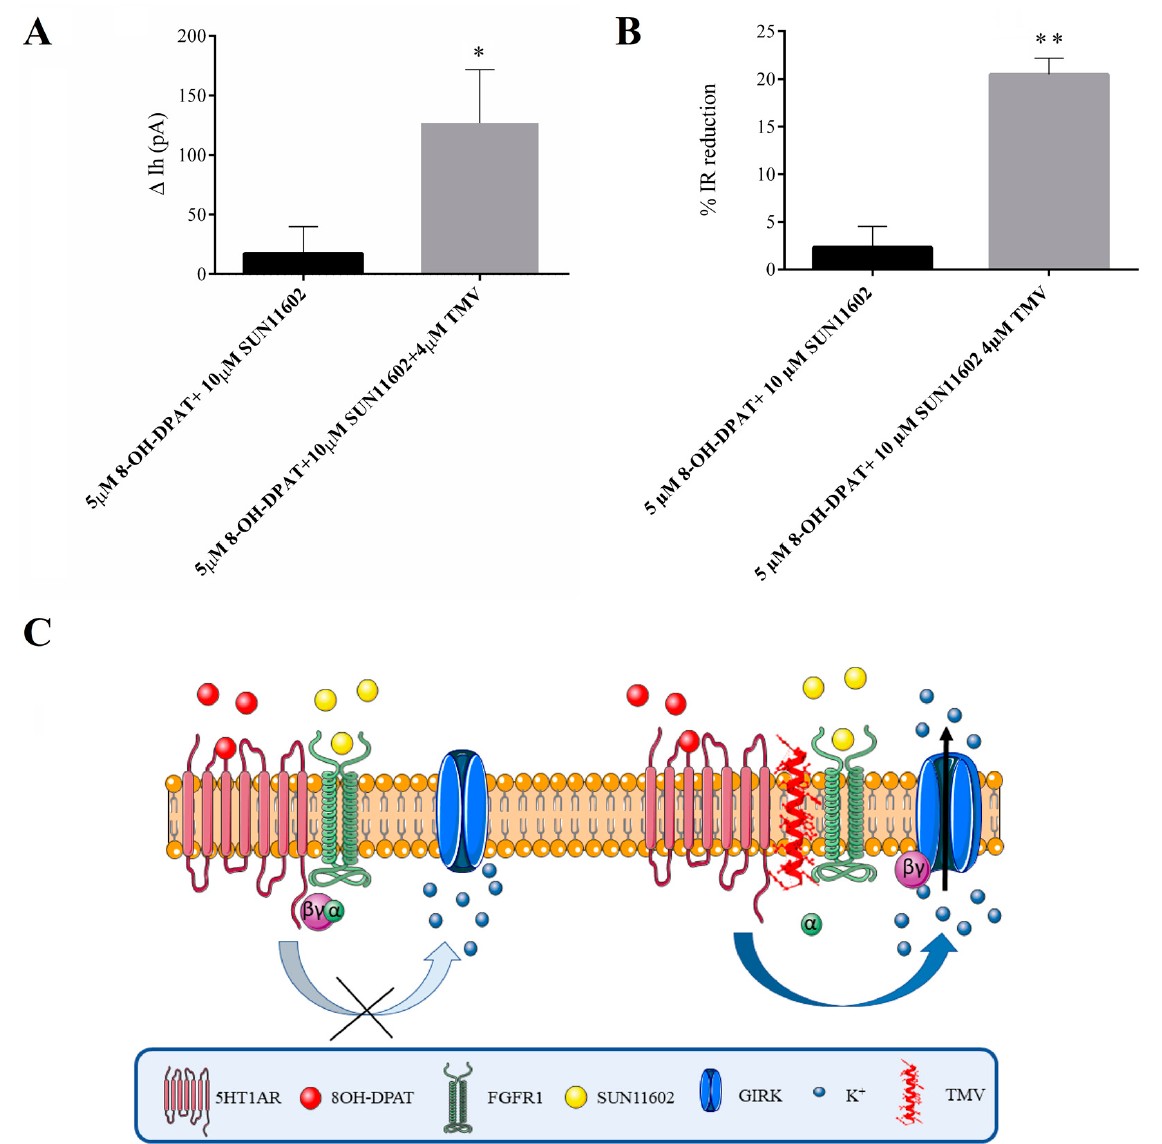
Figure 2. ( A ) TMV interfering peptide disrupts the receptor–receptor interaction within the 5HT1AR-FGFR1 heteroreceptor complex and significantly restores the hyperpolarizing current mediated by GIRK channel opening in CA2 of FSL rats. All data are expressed as mean ± SEM. Unpaired Student’s t -test * p < 0.05. Number of recorded cells (n): 8-OH-DPAT + SUN 11602 (8), SUN 11602 8-OH-DPAT + SUN 11602 + TMV (7). ( B ) TMV interfering peptide-mediated restoration of the GIRK channel opening mechanism reduces input resistance in CA2 neurons from FSL rats. All data are expressed as mean ± SEM. Unpaired student t -test ** p < 0.001. Number of recorded cells (n): 8-OH-DPAT + SUN 11602 (10), SUN 11602 8-OH-DPAT + SUN 11602 + TMV (7). ( C ) Cartoon showing the mechanism of action of the TMV interfering peptide: the peptide prevents the interaction between 5HT1A receptor and FGFR1 by overcoming the heteroreceptor-mediated inhibition of GIRK channel opening and favoring neuronal